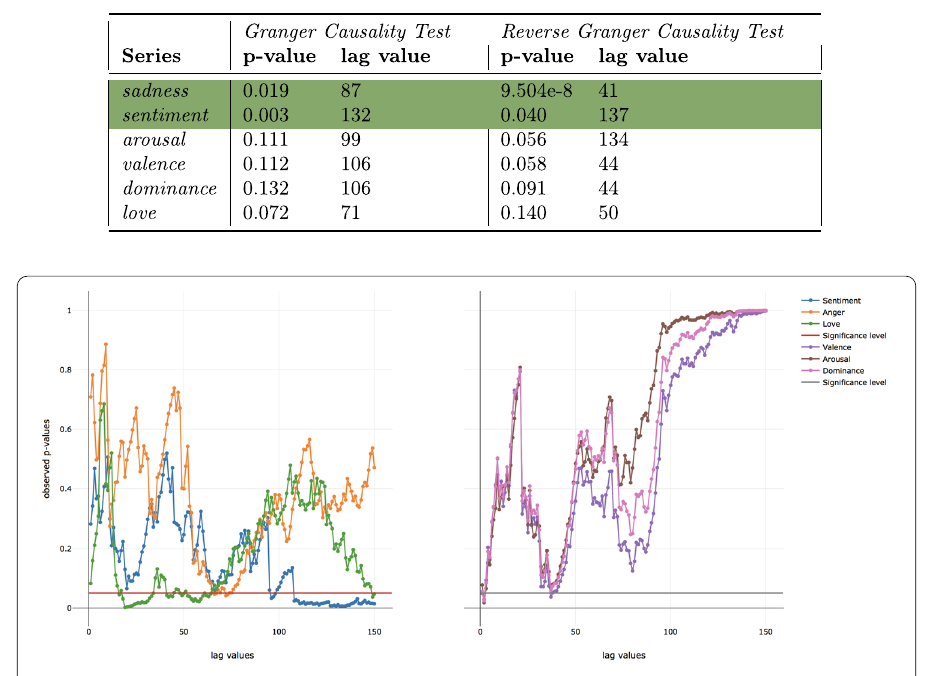
Table 4 Bitcoin Granger Causality tests. Minimum observed p -values and corresponding lag values for sadness and sentiment times series. We highlight in green the cases showing significant (direct or reverse) Granger causality